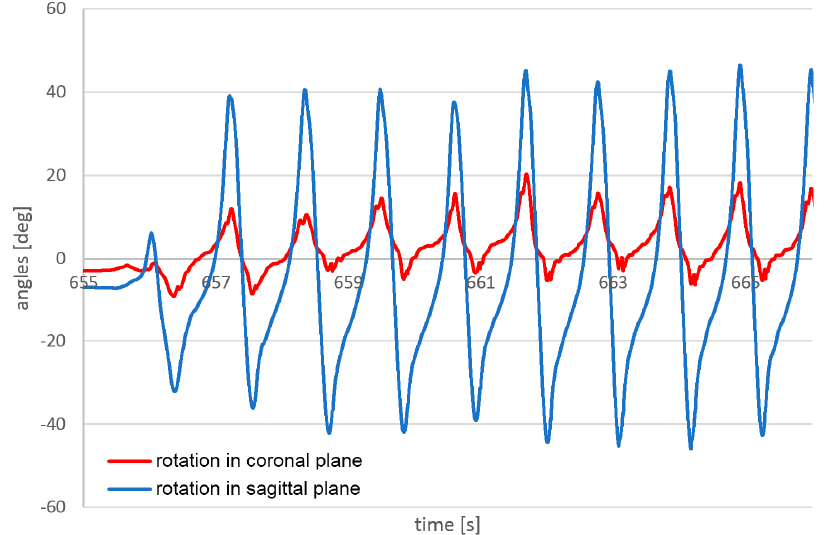
Figure 23. Angles measured on the left foot during walking by the flight controller.